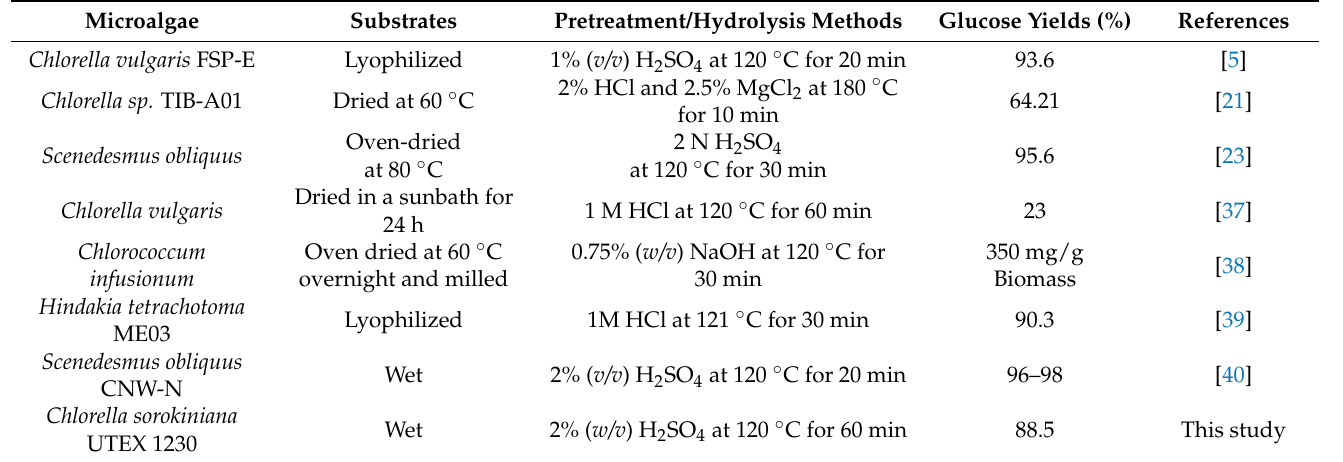
Table 2. Glucose yields of algae biomasses obtained by chemical